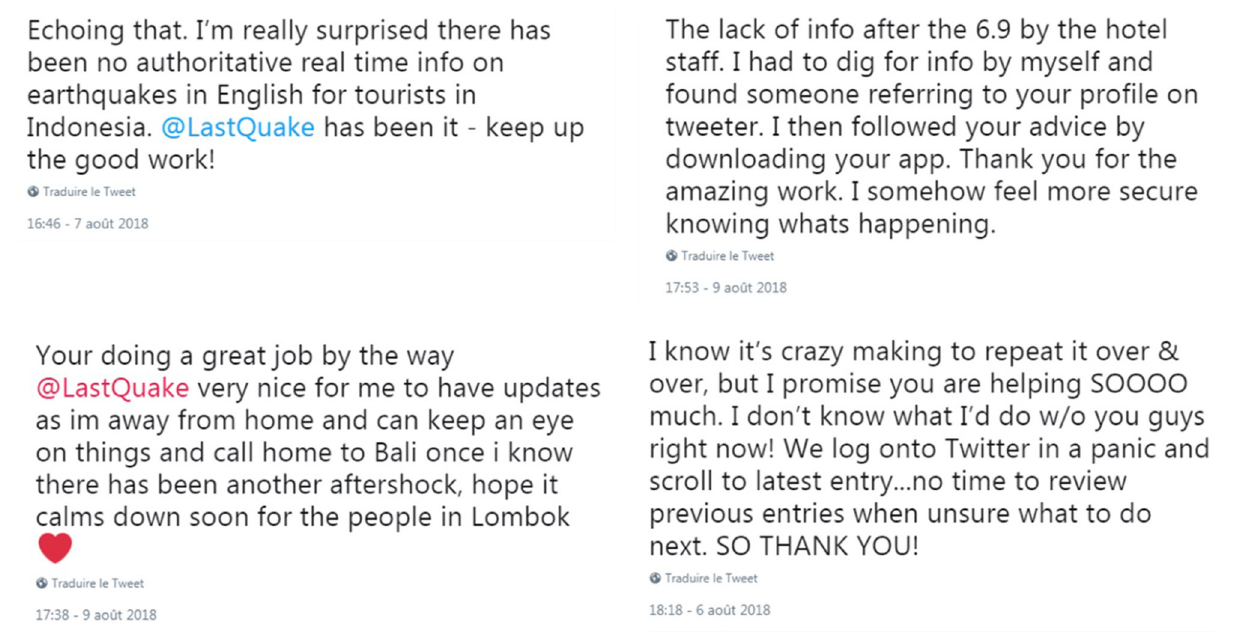
FIGURE3 A set of example tweets received during the Lombok (Indonesia) earthquake sequence illustrating the difficulty for tourists to find information in English, the usefulness of the @LastQuake information also for people from Indonesia’s diaspora and how timely people-centered information can reduce